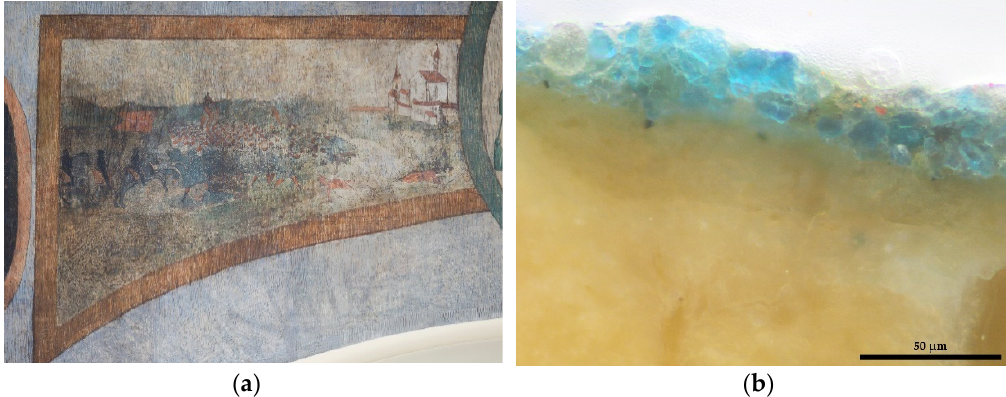
Figure 1. ( a ) Photo of the area where sample K52 was collected, photo by K. Opiłło; ( b ) cross-section of sample K52 with an azurite layer, magnification ×400.